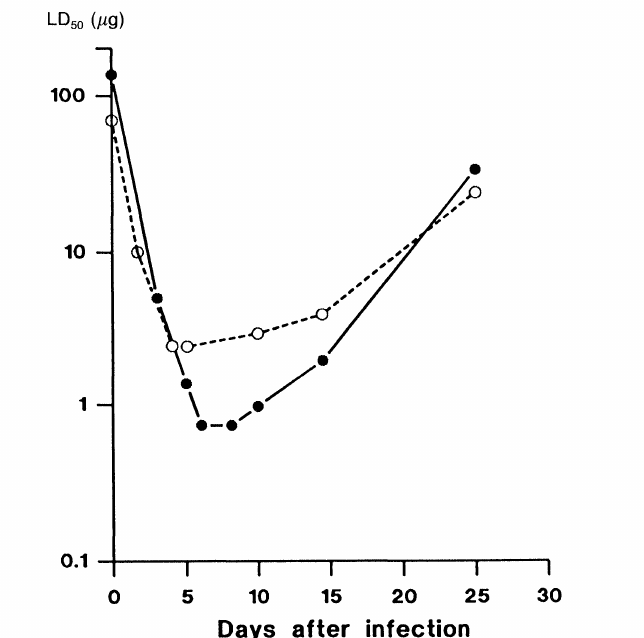
FIG. 2. Sensitization of mice to the lethal activity of LPS and HrTNF by sub-lethal infection with S. typhimurium. Mice (C3H/Tif) were infected with 2 104 CFU of S. typhimurium and on different days thereafter groups were challenged with different amounts of LPS and the LDso values were calculated. LPS, 0